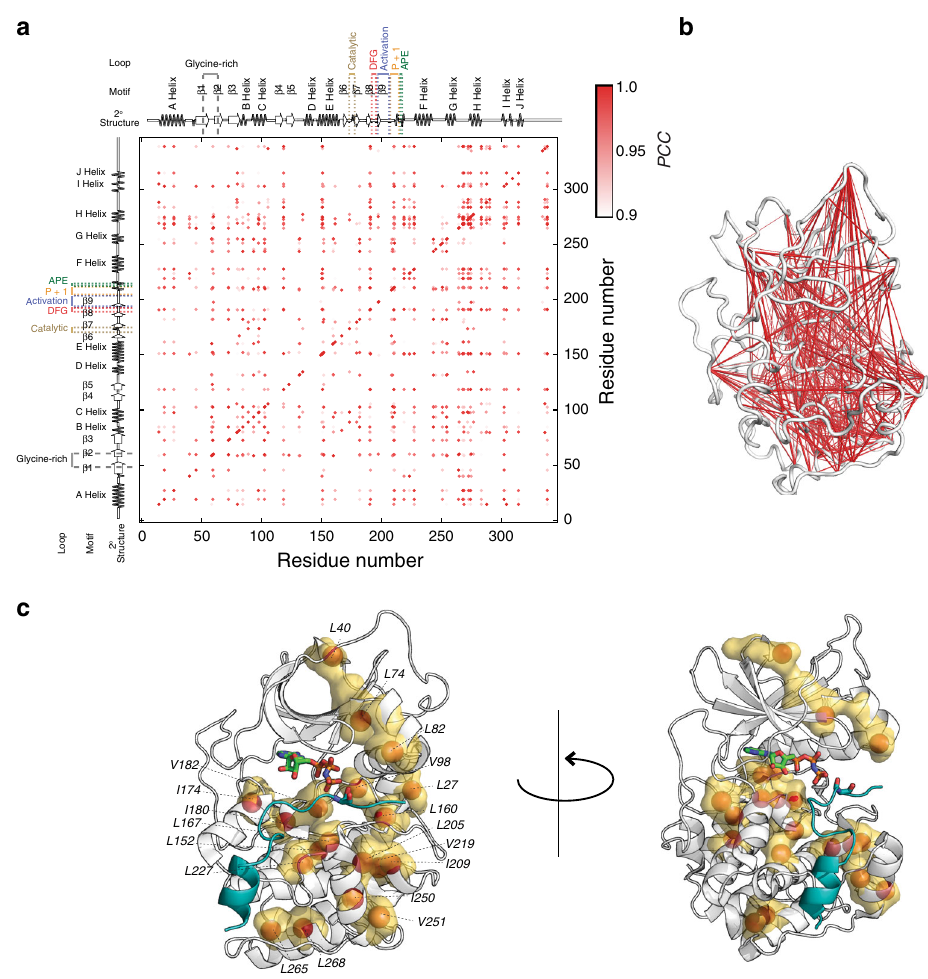
Fig. 3 Correlated motions orchestrate positive and negative cooperativity. a Covariance plot indicating the coordinated changes of methyl group order parameters ( O 2 ) throughout the entire kinase. The diagonal peaks in the plots represent the assigned methyl groups, while cross peaks indicate the degree of correlation of the methyl group O 2 using Pearson coef fi cient as a metric. Methyl group dynamics changes are considered coordinated when the Pearson coef fi cient is greater than 0.9. b Network plot connecting the methyl groups the highest values of covariance. c Mapping of the methyl groups that show a signi fi cant difference in order parameters upon forming the ternary complexes, i.e., PKA-C/ATP γ N/PKS 5 – 24 and PKA-C/ADP/pPKS 5 – 24 , from the binary complexes bound with nucleotide, respectively (see Supplementary Fig.